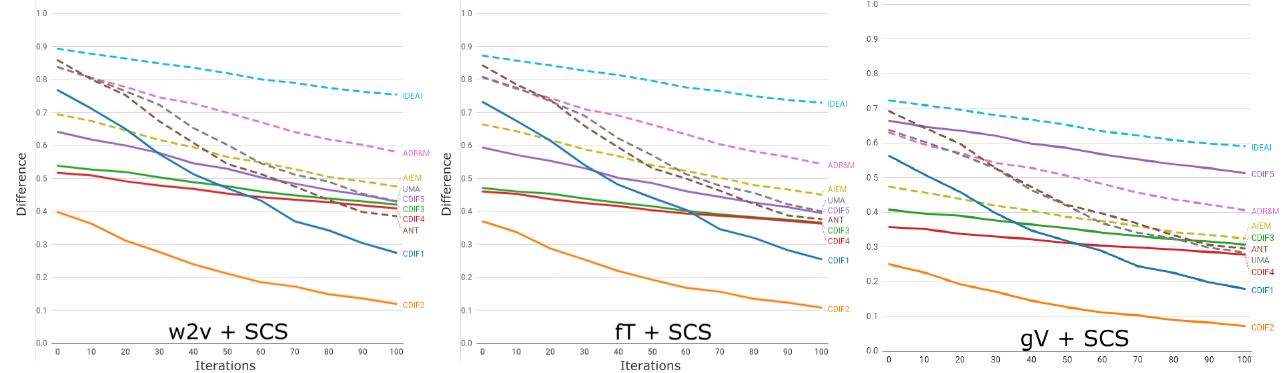
Figure 2. Behavior of SCS in the validation experiment. Some papers within the same group as the base paper (CDIF) exhibit smaller distances than papers from different research groups (labeled after the group name). More concretely, papers CDIF1 through CDIF4 show higher similarity than the rest of the papers in fT + SCS ( center ) and good performance in w2v + SCS ( left ) and gV + SCS ( right ). Moreover, in all cases, the distance decreases as the shared text between the files grows.